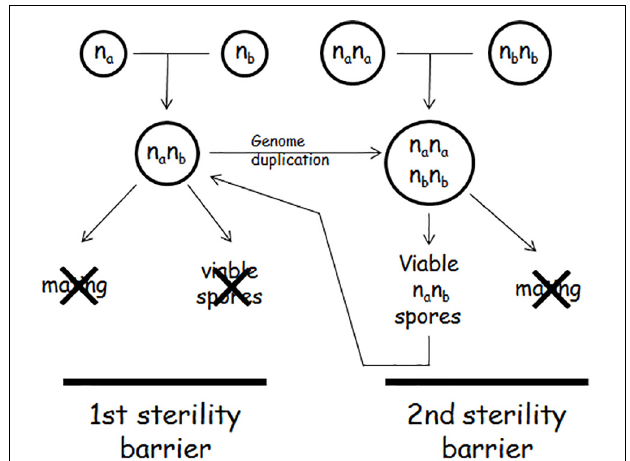
FIGURE 1 | The double sterility